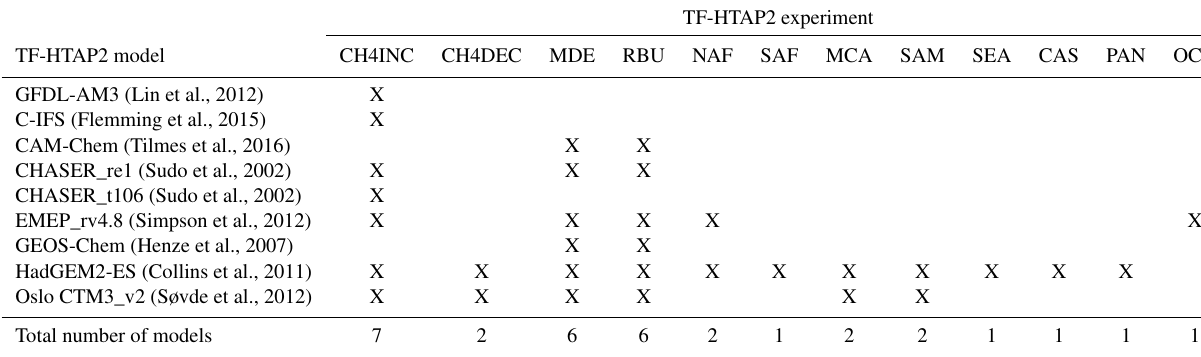
Table 3. Models contributing to each of the TF-HTAP2 emission perturbation experiments, in addition to those for the source regions of Europe, North America, south Asia and east